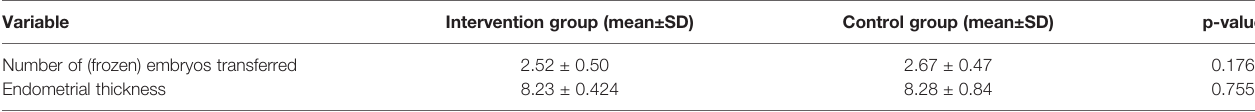
TABLE 4 | Second (Frozen) Transfer Characteristics.